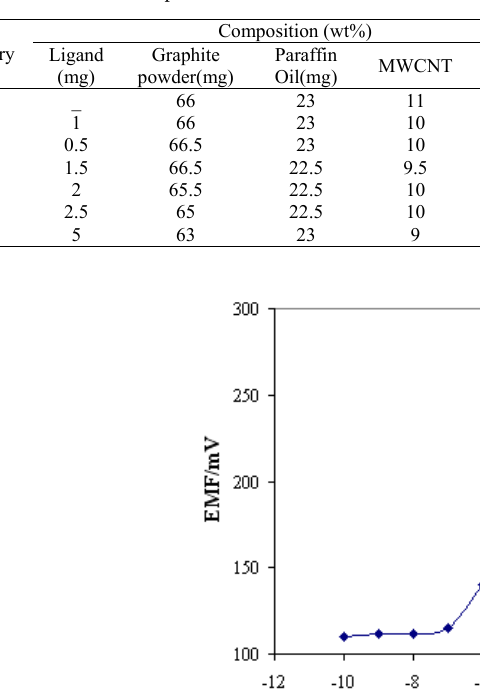
Table 1. The optimization of the MWCNTs- modified carbon paste mercury(II)-selective electrode.